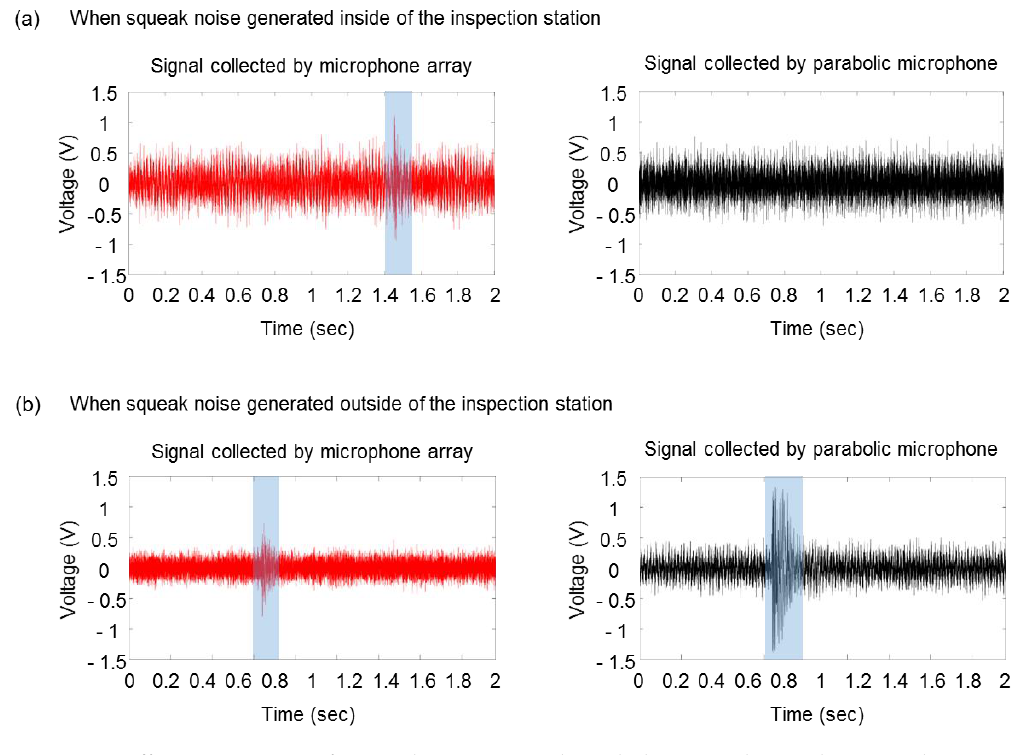
Figure 4. Different responses of microphone array and parabolic microphone when squeak noise is generated ( a ) inside of the inspection station and ( b ) outside of the inspection station. ( a ) A spark near 1.4 s is only found in signal of the microphone array. ( b ) A spark near 0.8 s can be found in both groups of microphones.